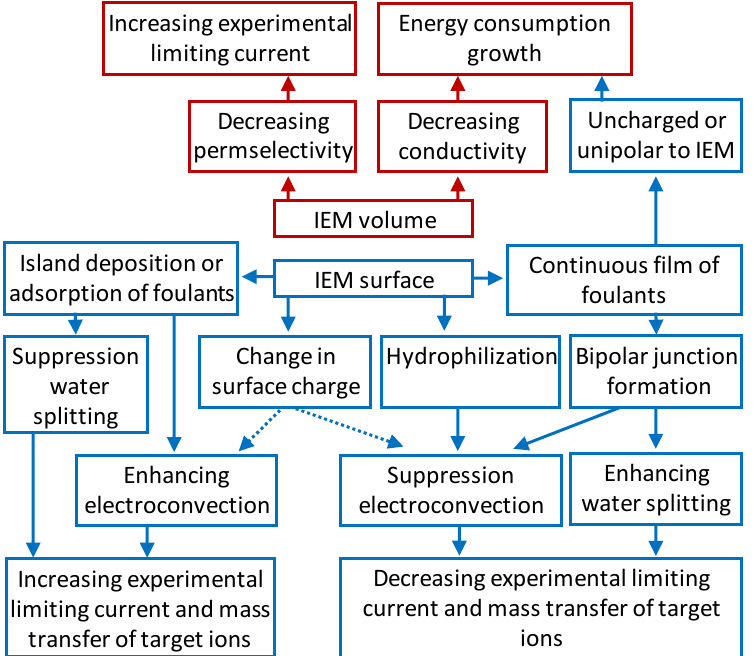
Figure 11. The scheme of the effect of fouling of the volume and surface of ion-exchange membranes on their behavior in an electric field.